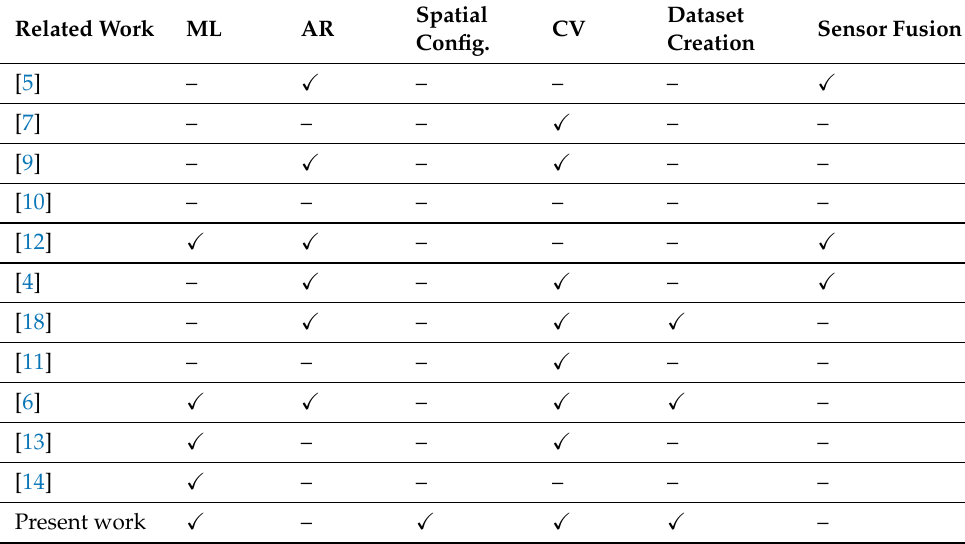
Table 1. Comparative Study of Literature work. Related